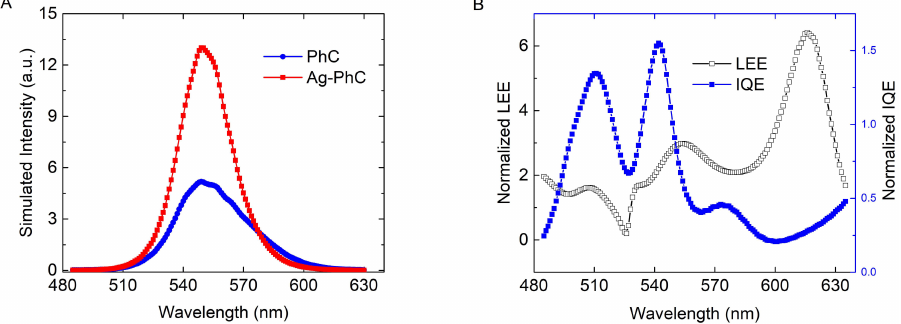
Figure 7. ( A ) Simulated CL spectra for Ag–PhC and PhC samples; ( B ) IQE and LEE of x-dipole normalized to those of the PhC sample at impinging point B for the Ag–PhC